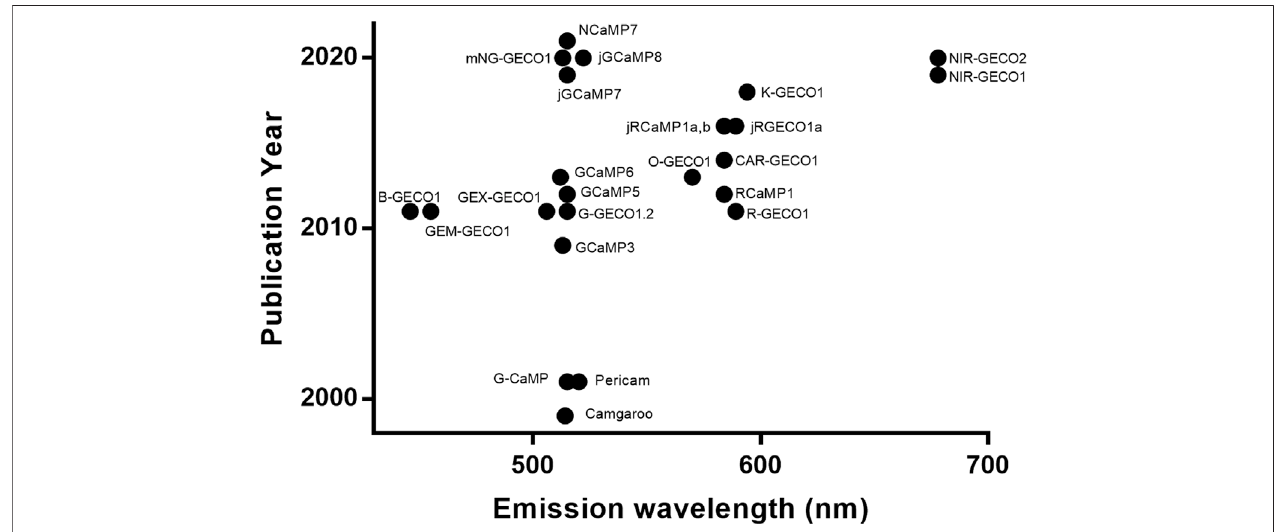
FIGURE 2 | Historical overview of GECI development. Selected GECIs are plotted with y -axis being the publication year and x -axis being the peak emission wavelength. The template FPs include ones based on BFP (Zhao et al., 2011), YFP (Baird et al., 1999), GFP (Nakai et al., 2001; Tian et al., 2009; Zhao et al., 2011; Akerboom et al., 2013; Dana et al., 2019; Zhang et al., 2021), mNeonGreen (Subach et al., 2020; Zarowny et al., 2020), mApple (Zhao et al., 2011; Dana et al., 2016), mRuby (Akerboom et al., 2013; Dana et al., 2016), FusionRed (Shen et al., 2018), and mIFP (Qian et al., 2019, 2020).